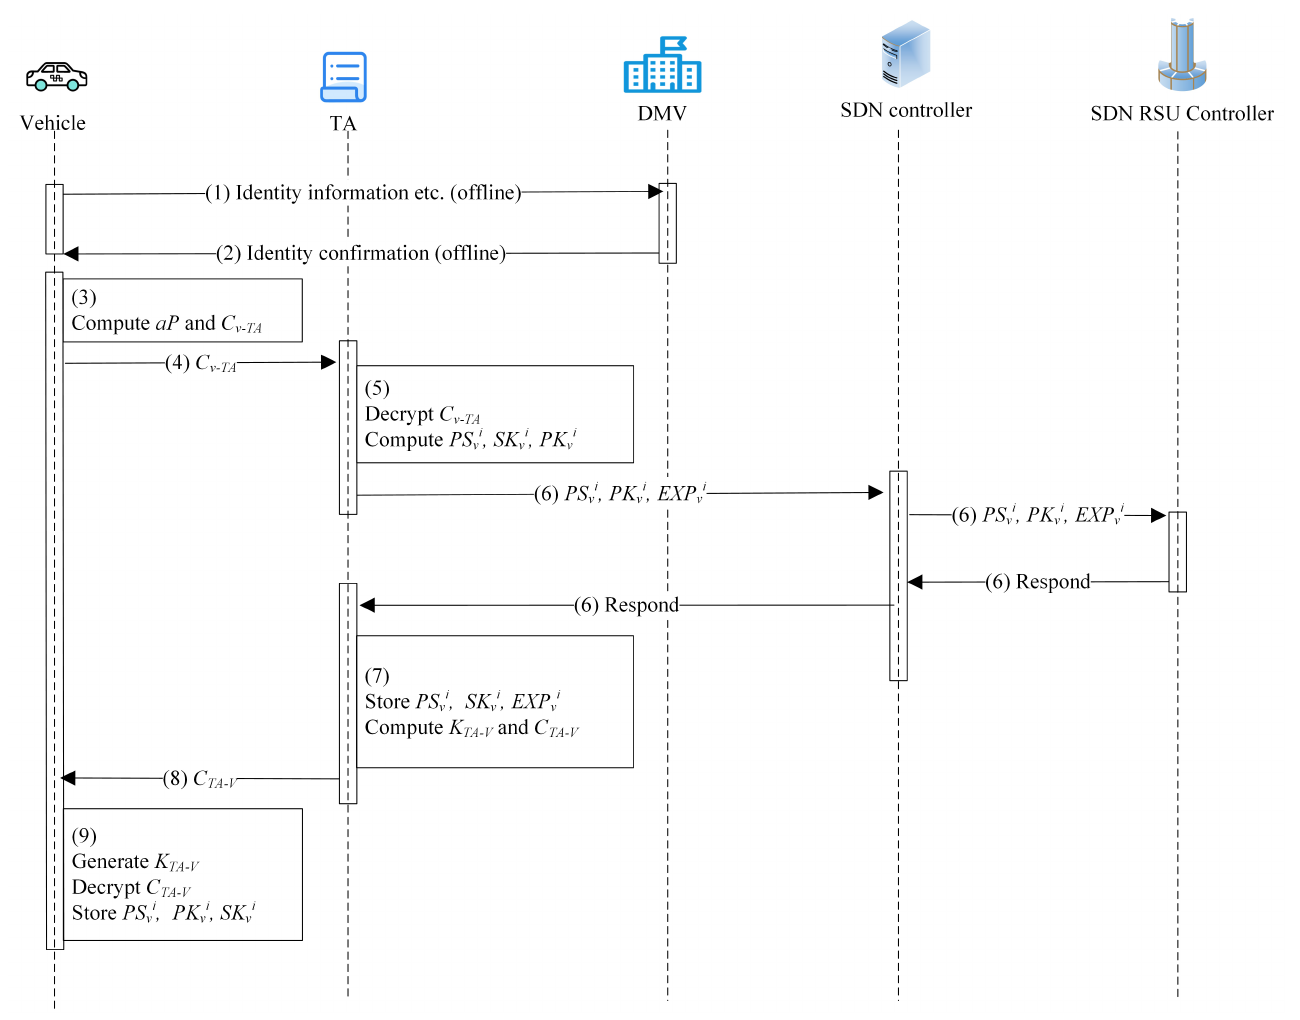
Figure 4. Vehicle registration